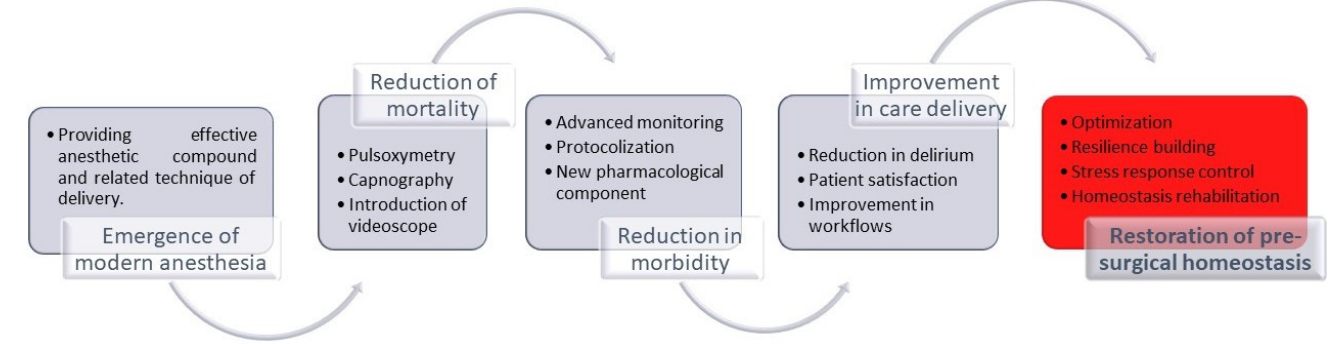
Figure 1 . Anesthesia historical milestone . Figure 1. Anesthesia historical